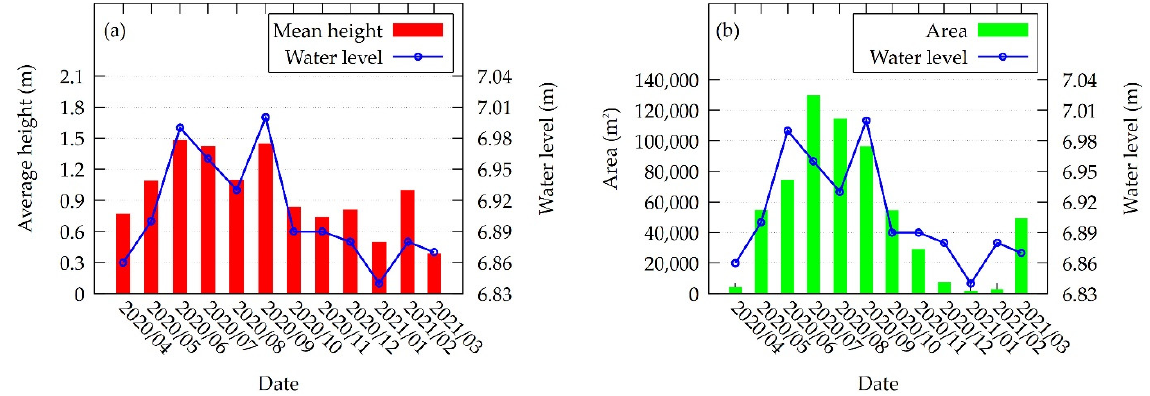
Figure 13. Water level profiles simulated by the 2D hydraulic model using the dynamic roughness model with: ( a ) the vegetation average height and ( b ) vegetation area from April 2020 to March 2021.